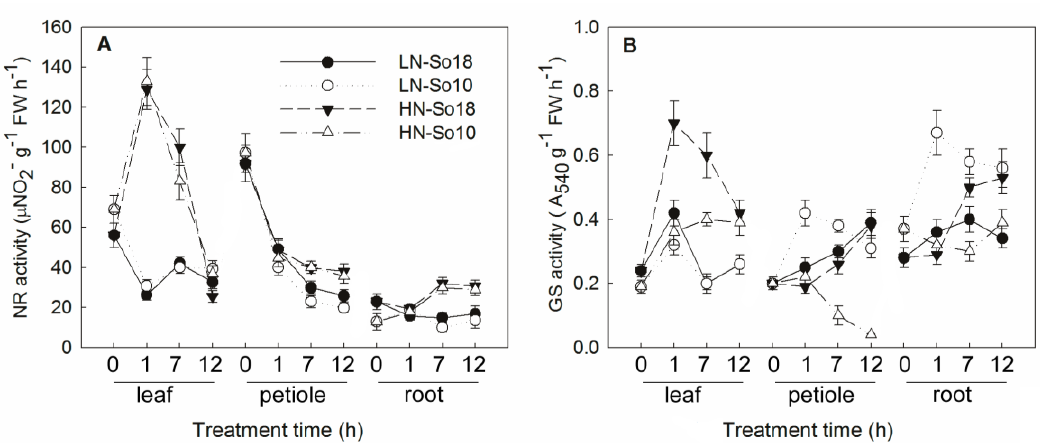
Figure 4. The activities of nitrate reductase (NR) ( A ) and glutamine synthetase (GS) ( B ) in shoots of two spinach varieties under low (0.5 mmol·L −1 ) and high nitrate (15 mmol·L −1 ) treatments. Values are represented as mean ± SD, n = 3. LN-So18, So18 treated with low nitrate concentration; LN-So10, So10 treated with low nitrate concentration; HN-So18, So18 treated with high nitrate concentration; and HN-So10, So10 treated with high nitrate concentration.